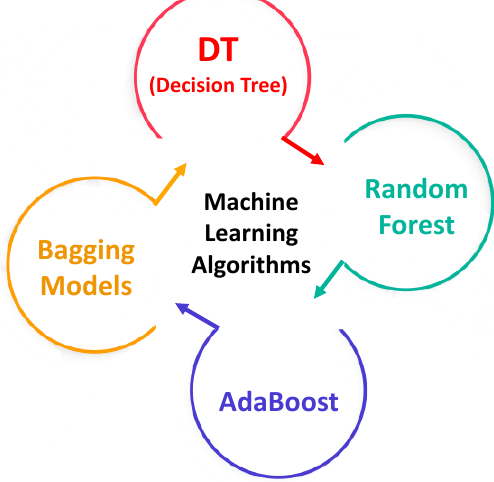
Figure 3. Algorithm flowchart.